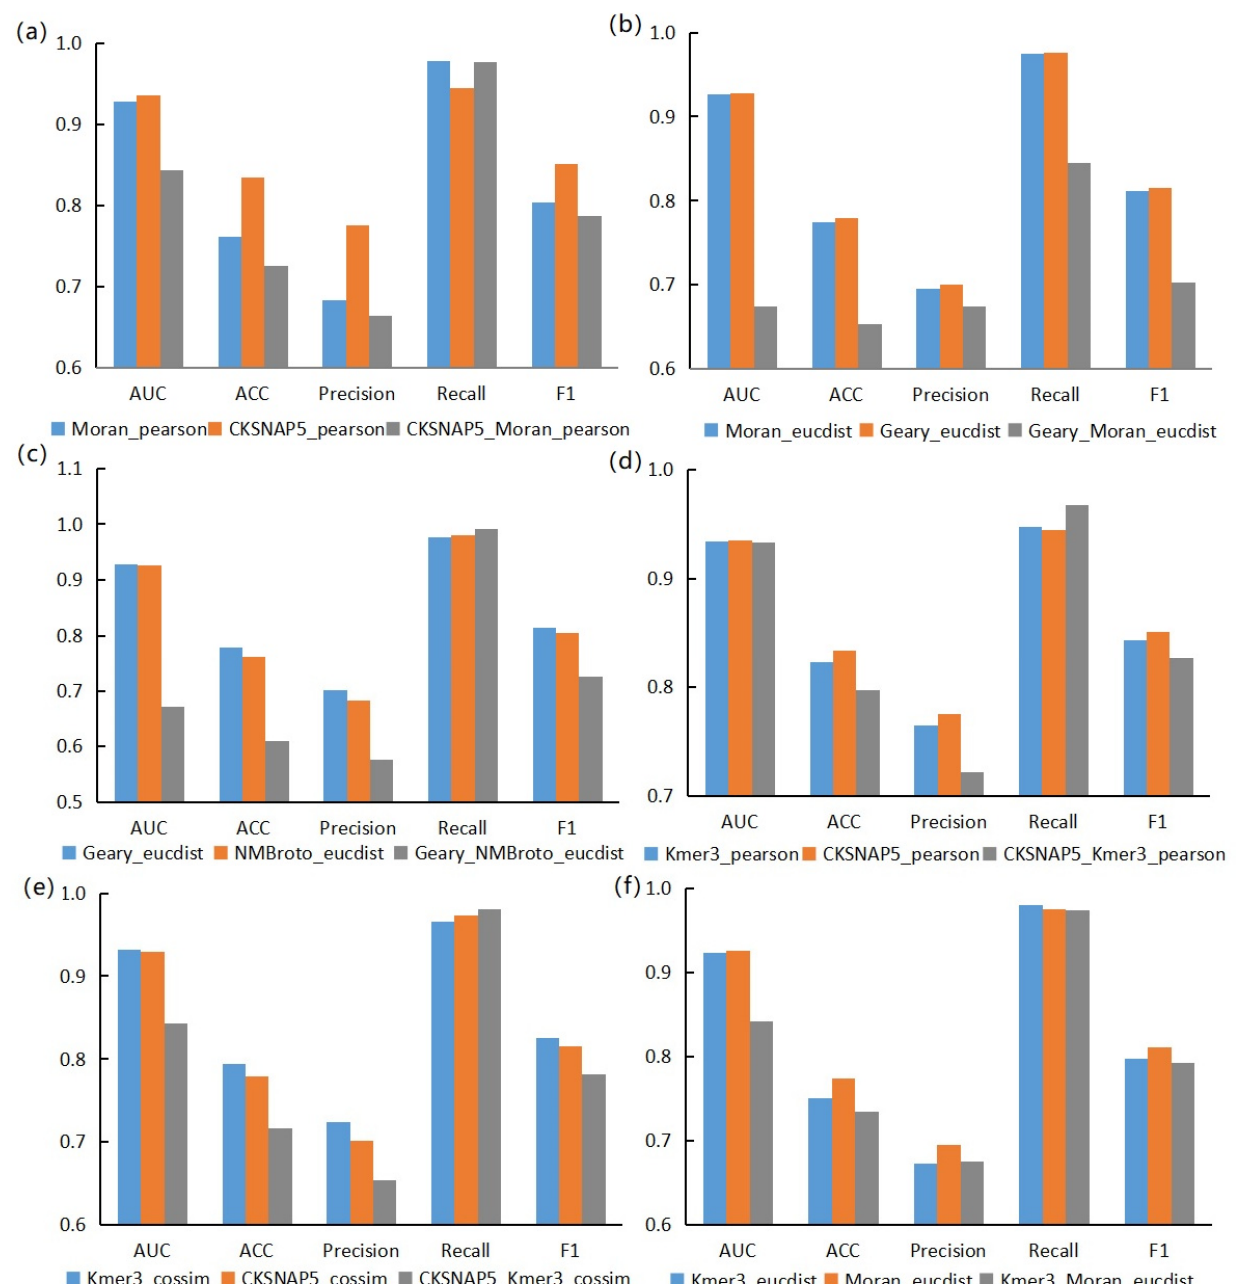
Figure 4. Example diagram of dependence of dual feature models on single feature models. ( a ) is a comparison between the Pearson correlation coefficient model based on Moran feature (blue), the Pearson correlation coefficient model based on CKSNAP feature (dark orange) and the Pearson correlation coefficient model based on Moran+CKSNAP combined feature (gray). ( b ) is a comparison between the Euclidean distance model based on Moran feature (blue), the Euclidean distance model based on Geary feature (dark orange) and the Euclidean distance model based on Moran+Geary combined feature (gray). ( c ) is a comparison between the Euclidean distance model based on Geary feature (blue), the Euclidean distance model based on NMBroto feature (dark orange) and the Euclidean distance model based on Geary+NMBroto combined feature (gray). ( d ) is a comparison between the Pearson correlation coefficient model based on Kmer feature (blue), the Pearson correlation coefficient model based on CKSNAP feature (dark orange) and the Pearson correlation coefficient model based on Kmer+CKSNAP combined feature (gray). ( e ) is a comparison between the cosine similarity model based on Kmer feature (blue) and the cosine similarity model based on